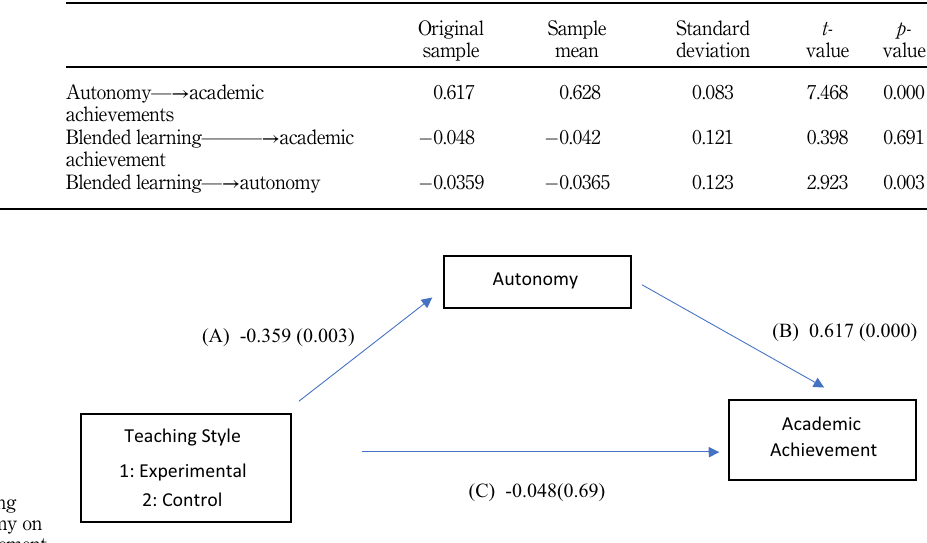
Figure 2. Model 2-mediating effect of autonomy on academic